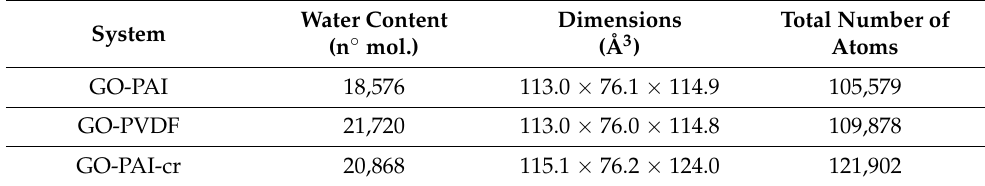
Table 2. Multilayer supported systems